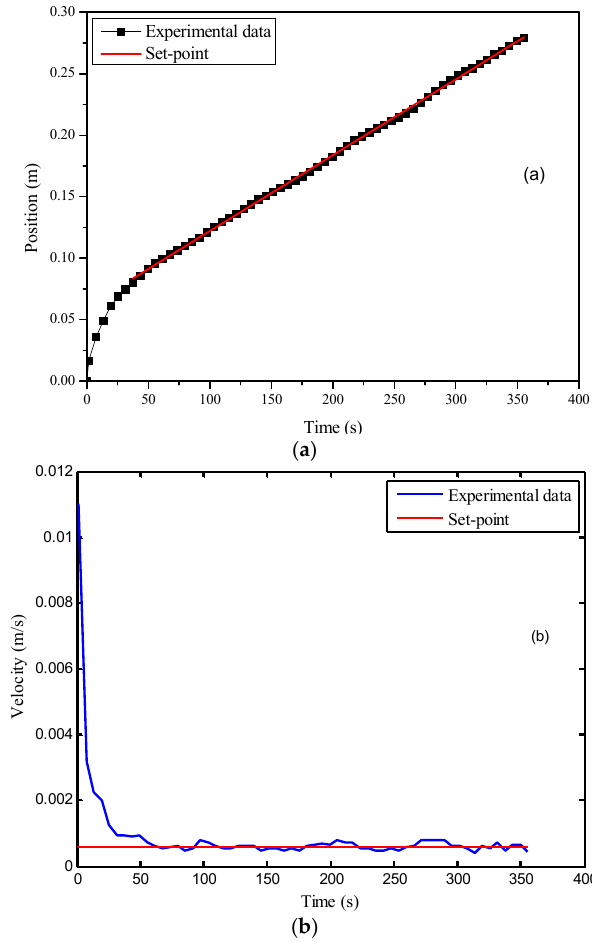
Figure 12. Control results of the model-assisted cascade controller under model mismatch: ( a ) time vs. flow front position; ( b ) time vs. flow front velocity.